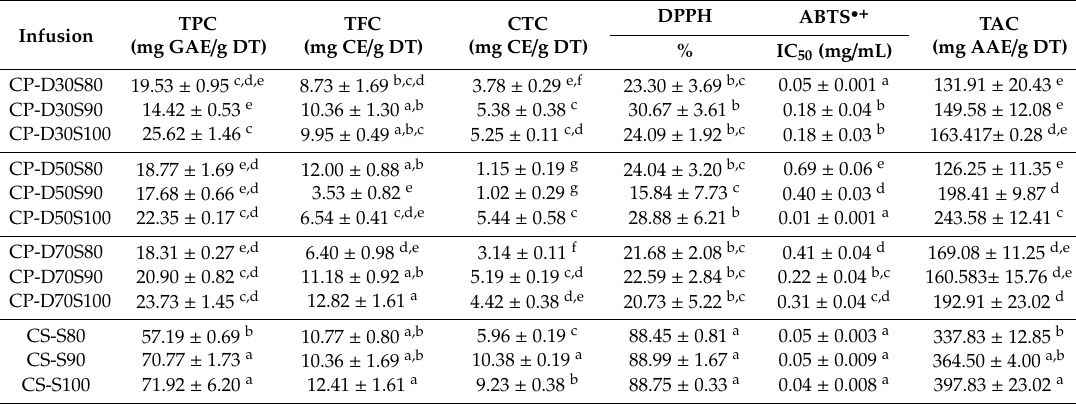
Table 2. Total phenolic, flavonoids, and tannins contents, free radical scavenging activity, and total antioxidant capacity of Cunila polyantha and Camellia sinensis infusions obtained with di ff erent drying and steeping